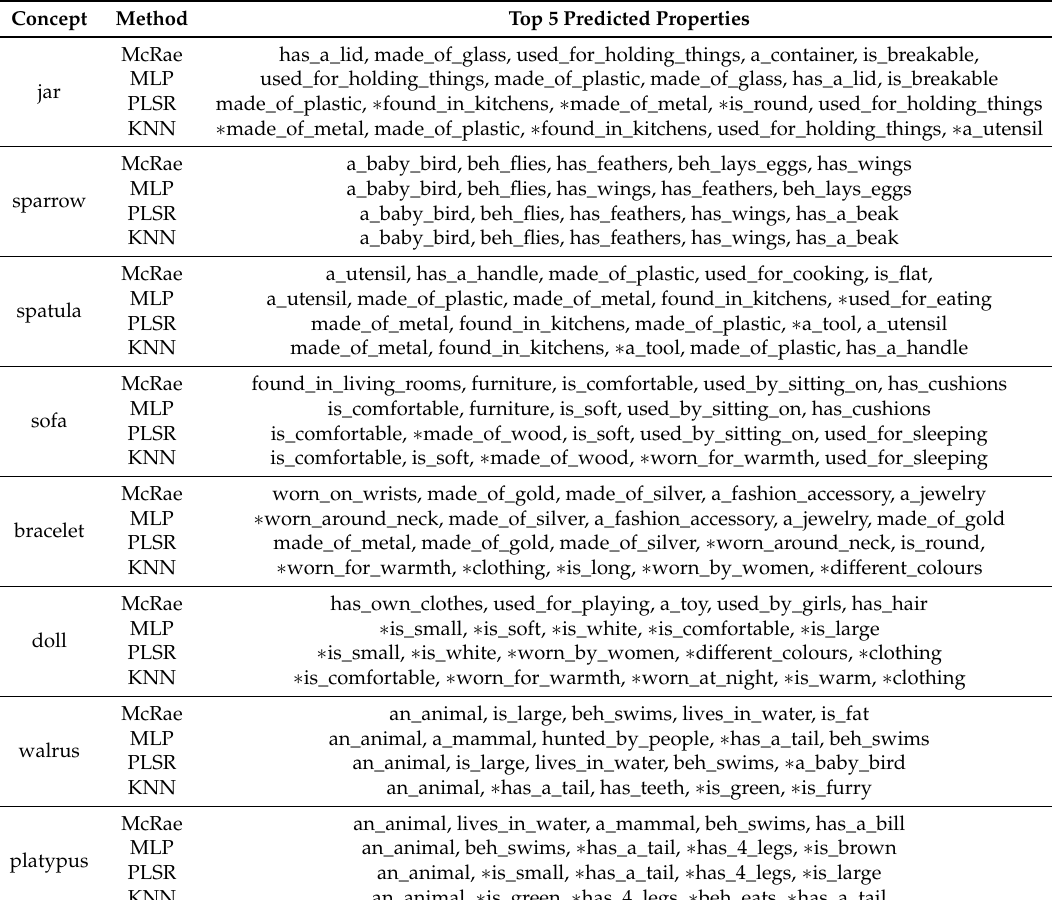
Table 6. Top 5 properties returned by MLP, PLSR, and KNN. Properties annotated with ∗ are not listed in